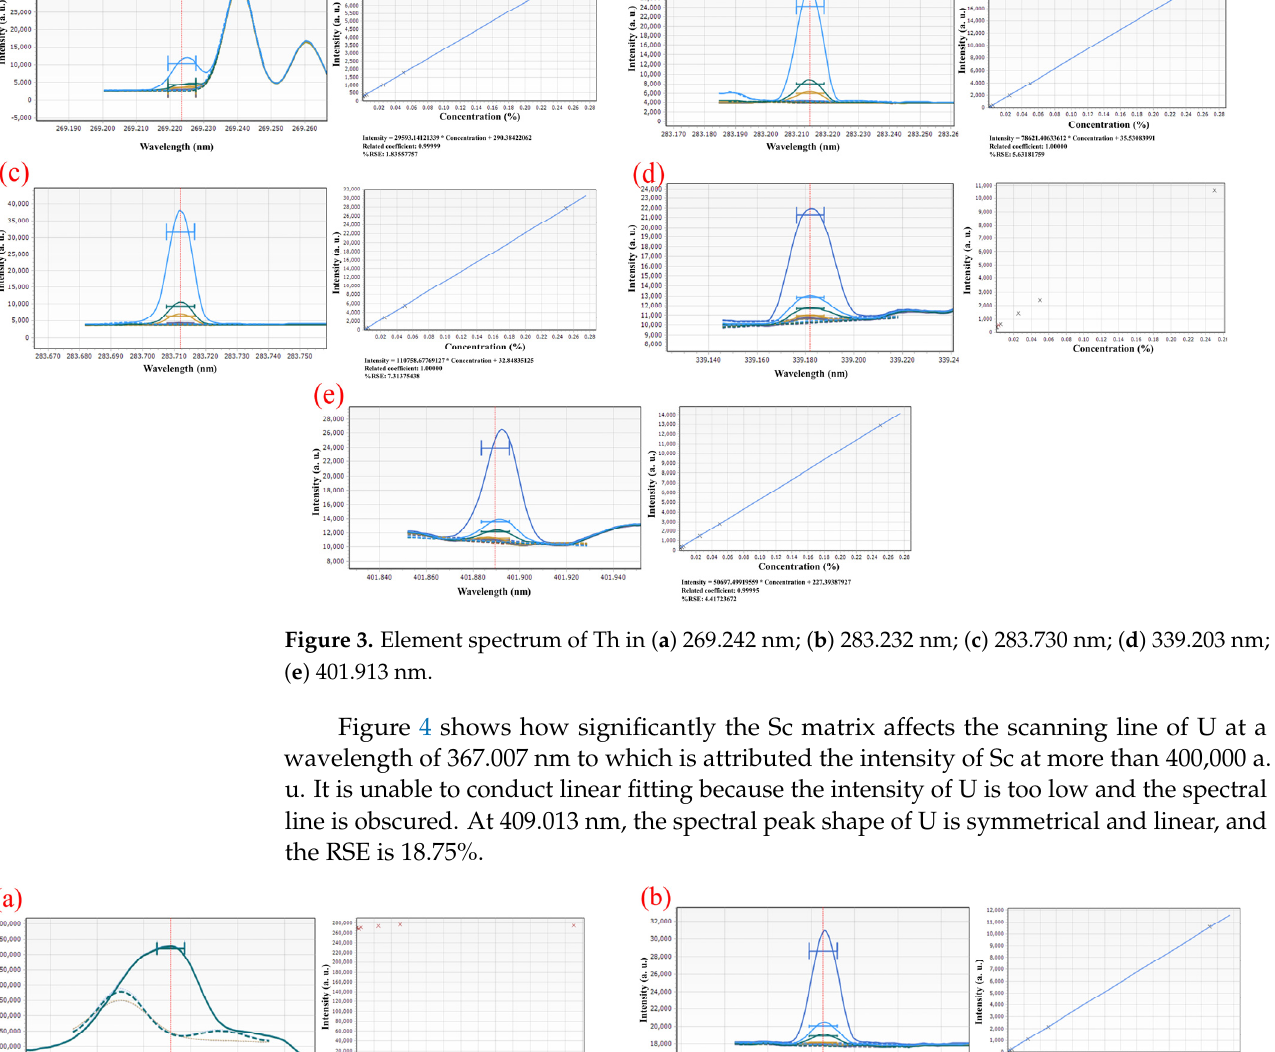
Figure 4. Element spectrum of U in ( a ) 409.013 nm; ( b ) 367.007 nm.